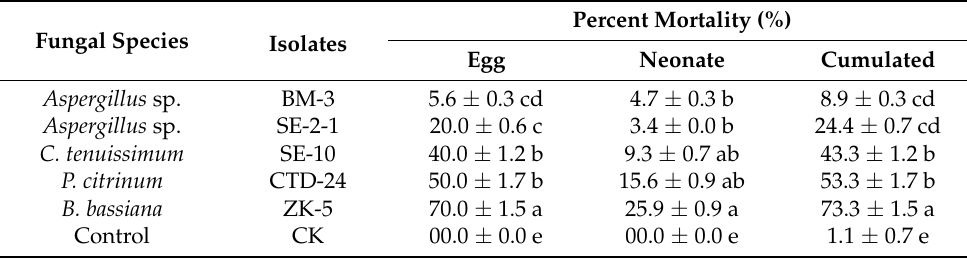
Table 5. Effects of fungal isolates on cumulative mortalities of eggs and neonates at 1 × 10 7 conidia mL − 1 .